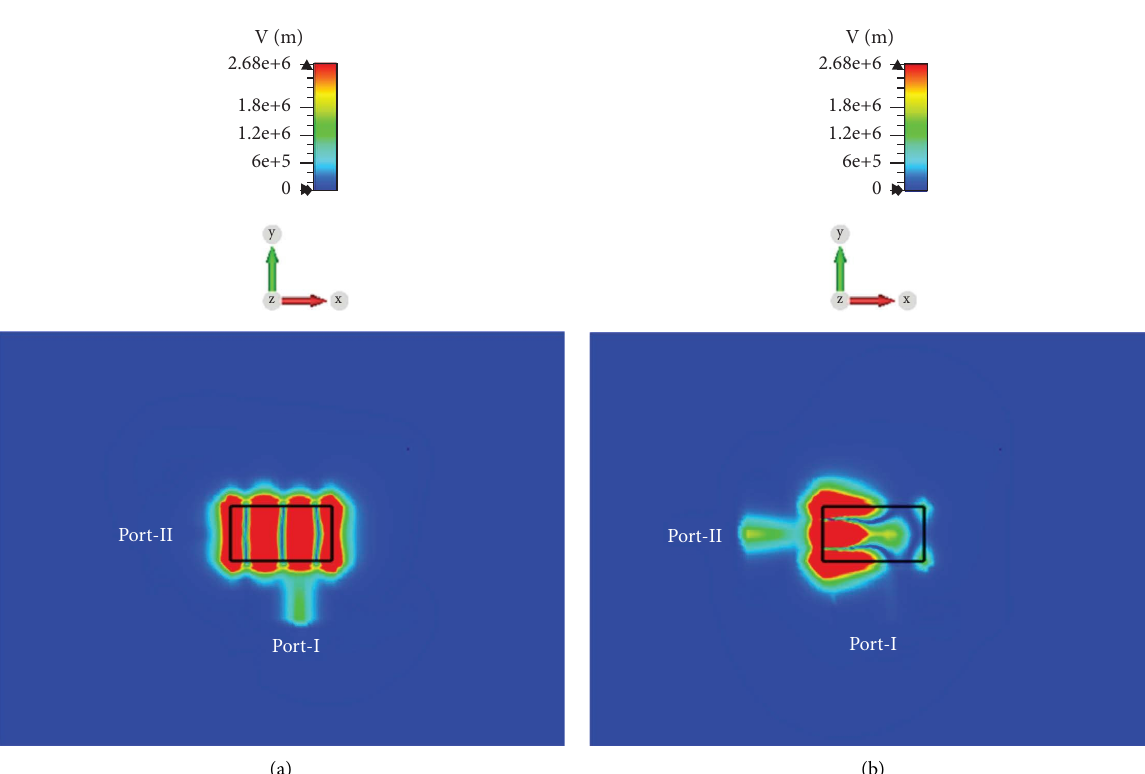
Figure 3: Field distributions: (a) at 1.83THz, when Port-1 is excited. (b) At 2.06THz, when Port-2 is excited.